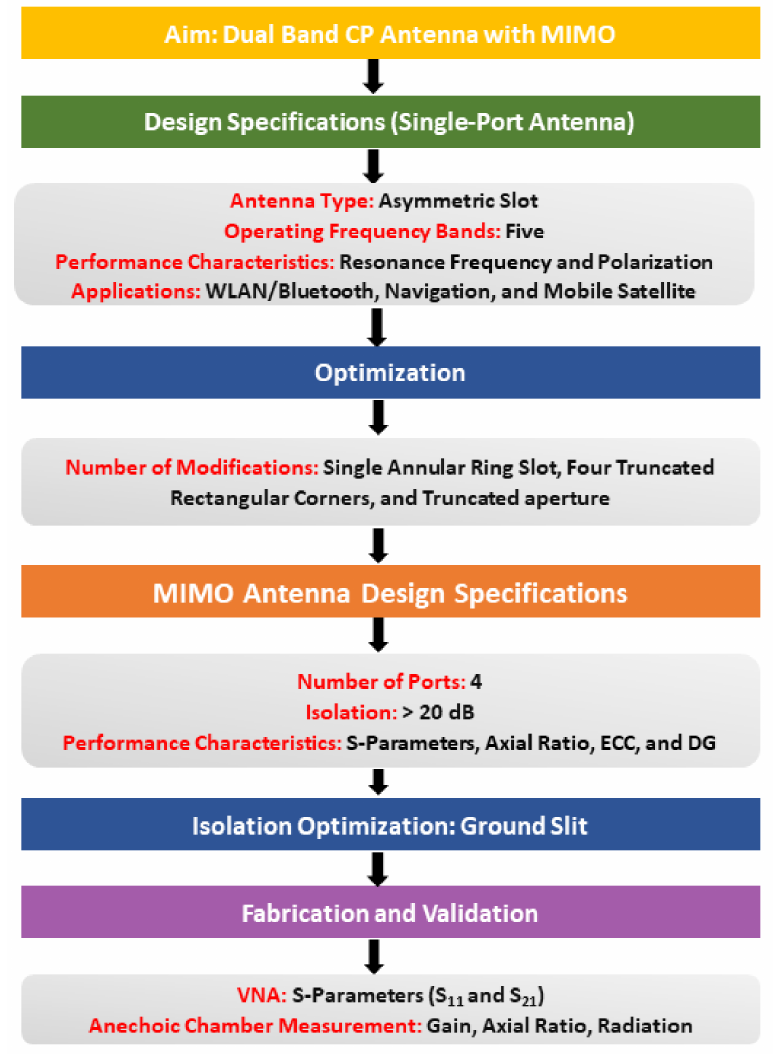
Figure 1. Systematic representation of the design